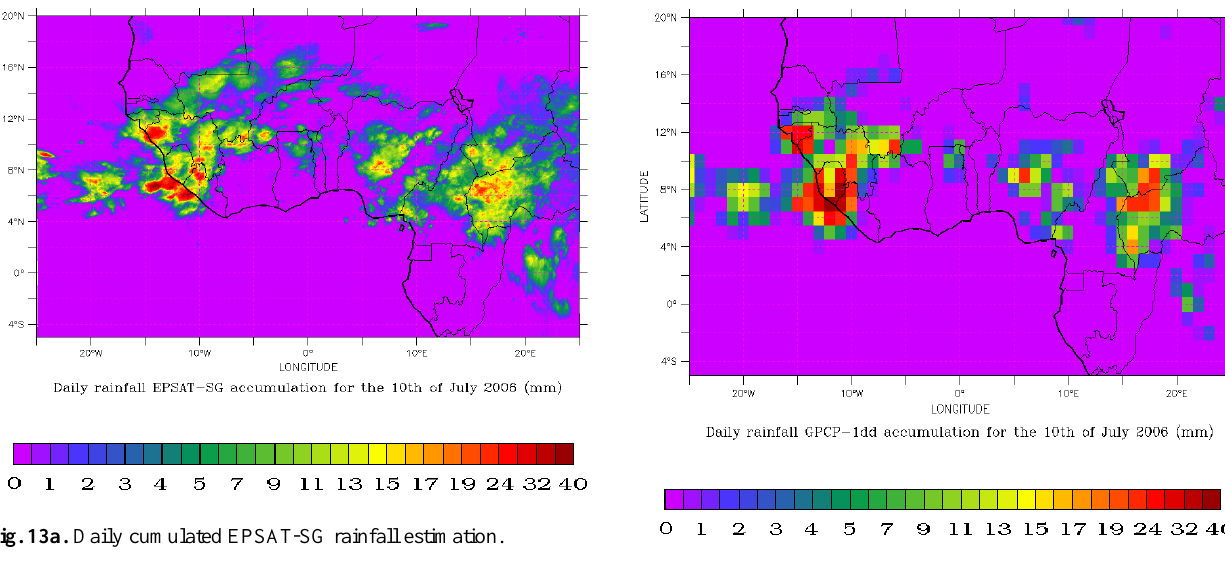
Figure 13.b. GPCP-1dd rainfall estimation Fig. 13b. GPCP-1dd rainfall estimation. region in West Africa during the 2004 rainy season. A